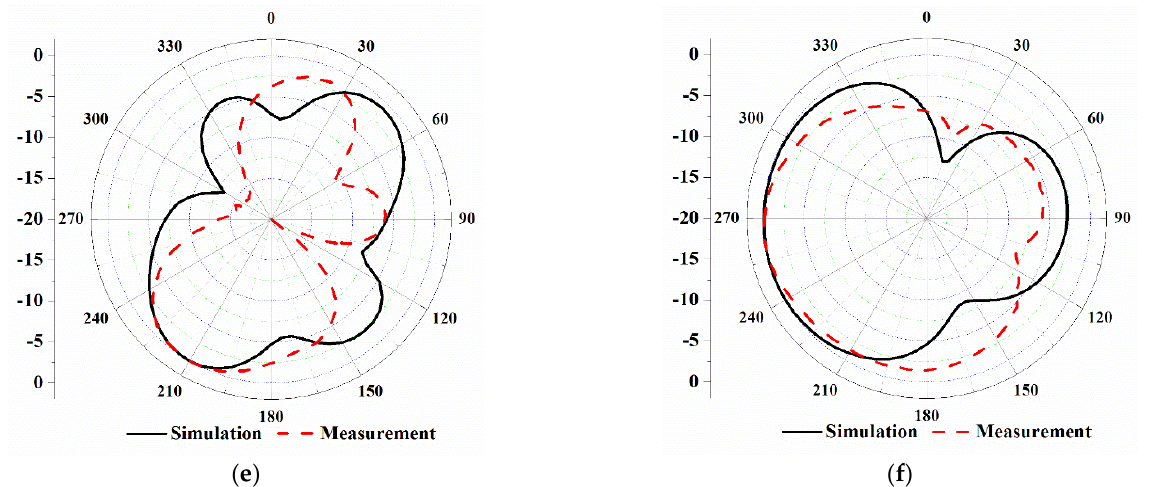
Figure 11. Simulated (solid line) and measured (dashed line) radiation patterns of the antenna. ( a ) E-plane @ 30 MHz. ( b ) H-plane @ 30 MHz. ( c ) E-plane @ 60 MHz. ( d ) H-plane @ 60 MHz. ( e ) E-plane @ 90 MHz. ( f ) H-plane @ 90 MHz.